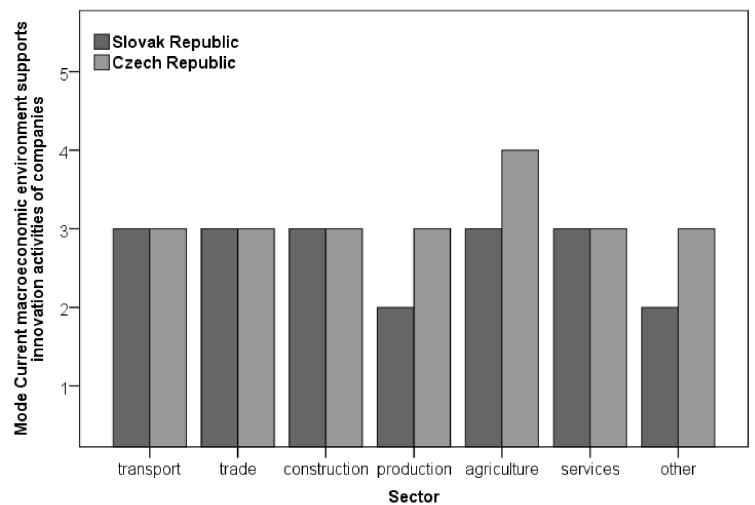
Figure 3. Current macroeconomic environment supports innovation activities of